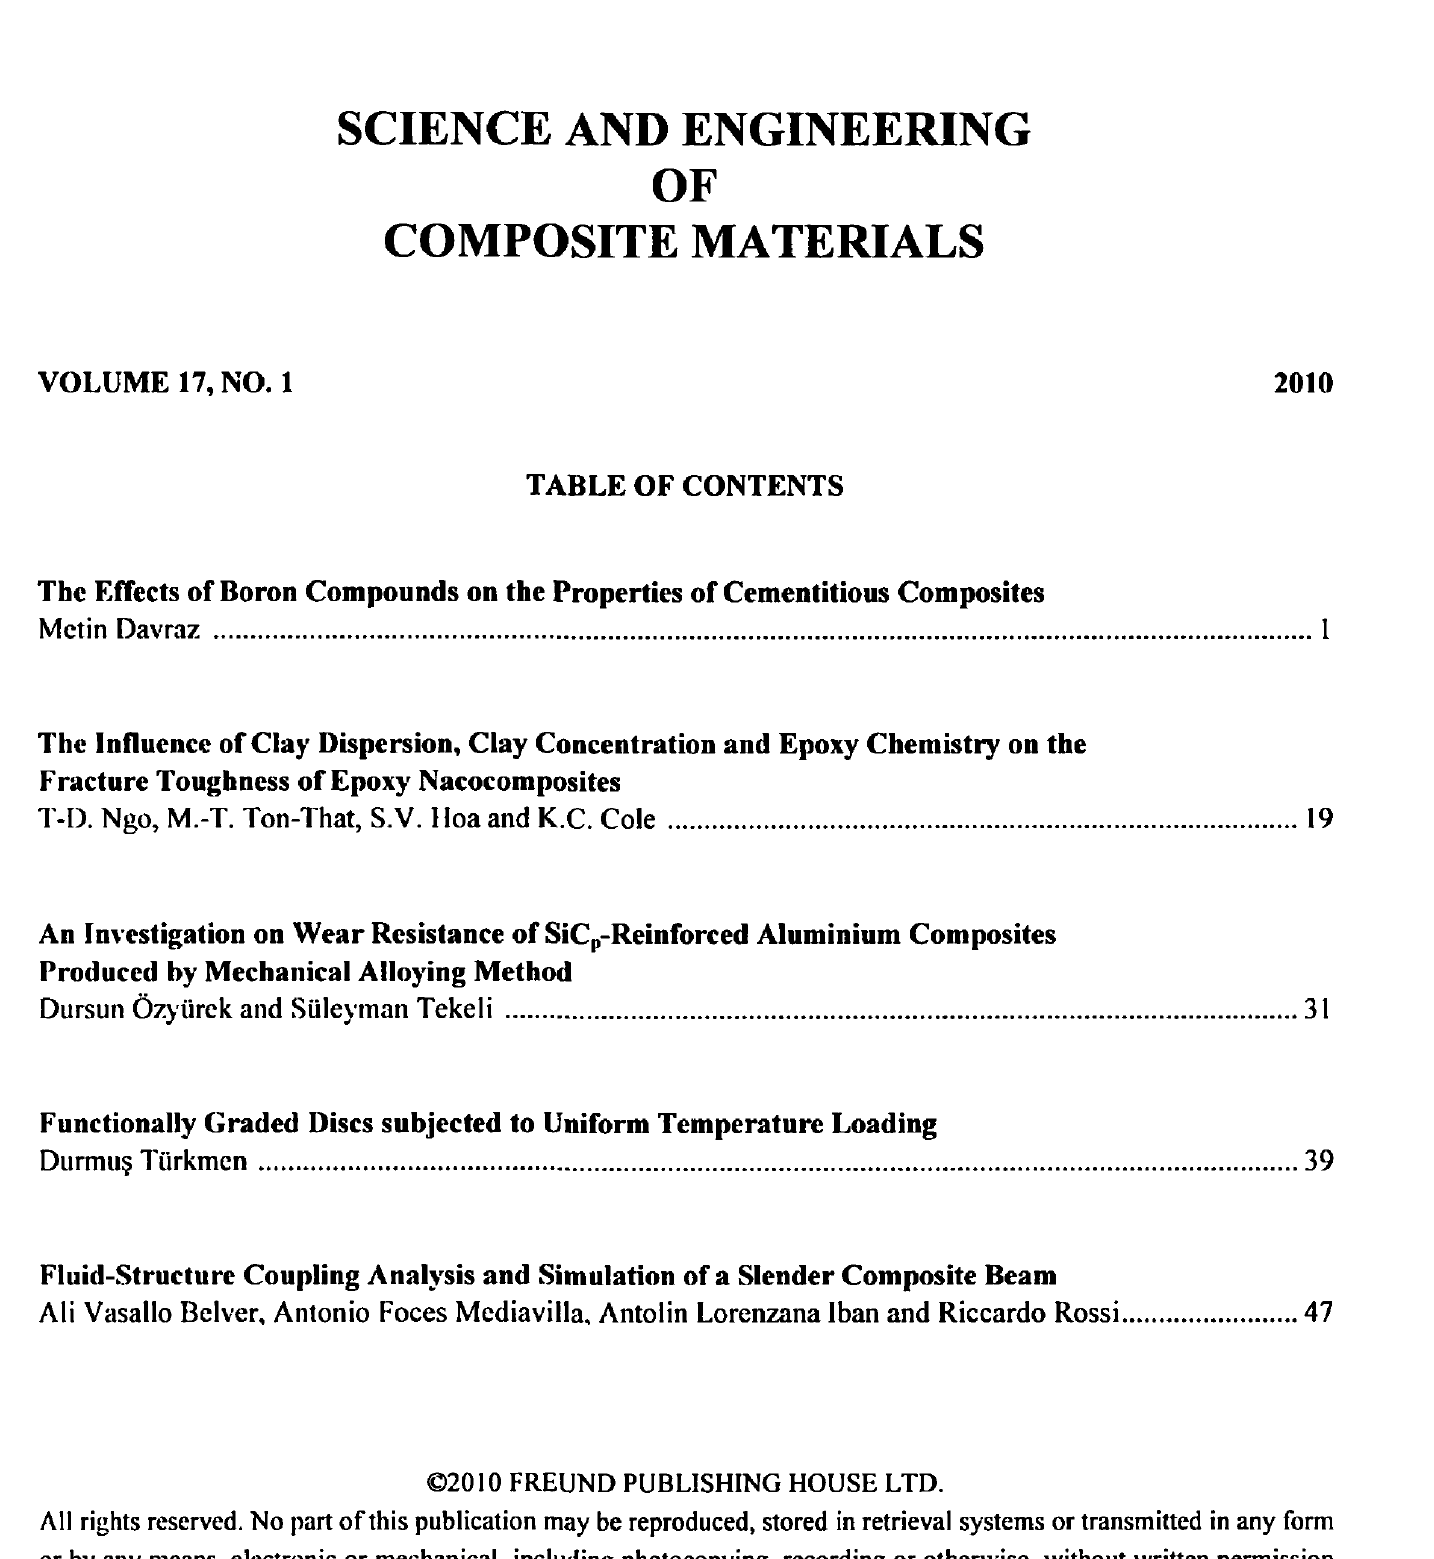
Functionally Graded Discs subjected to Uniform Temperature